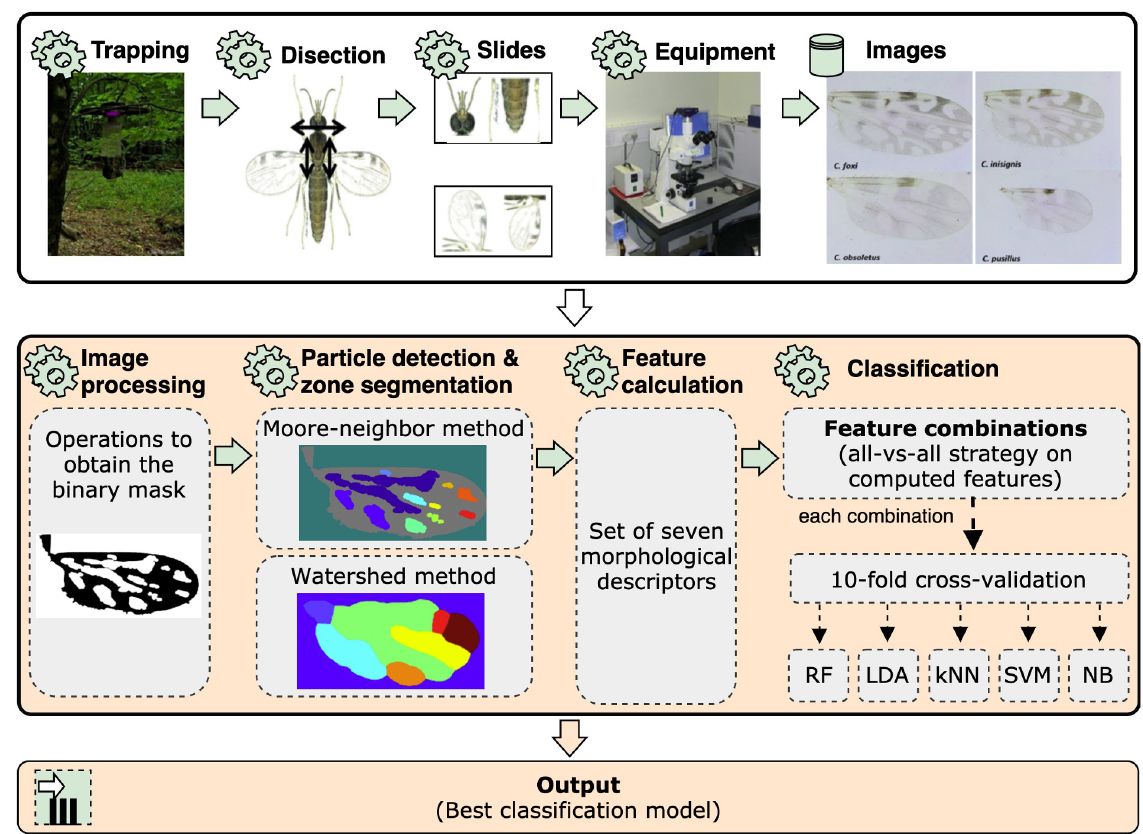
Fig 1. Schematic of the entire research workflow, including the proposed method (central and lower